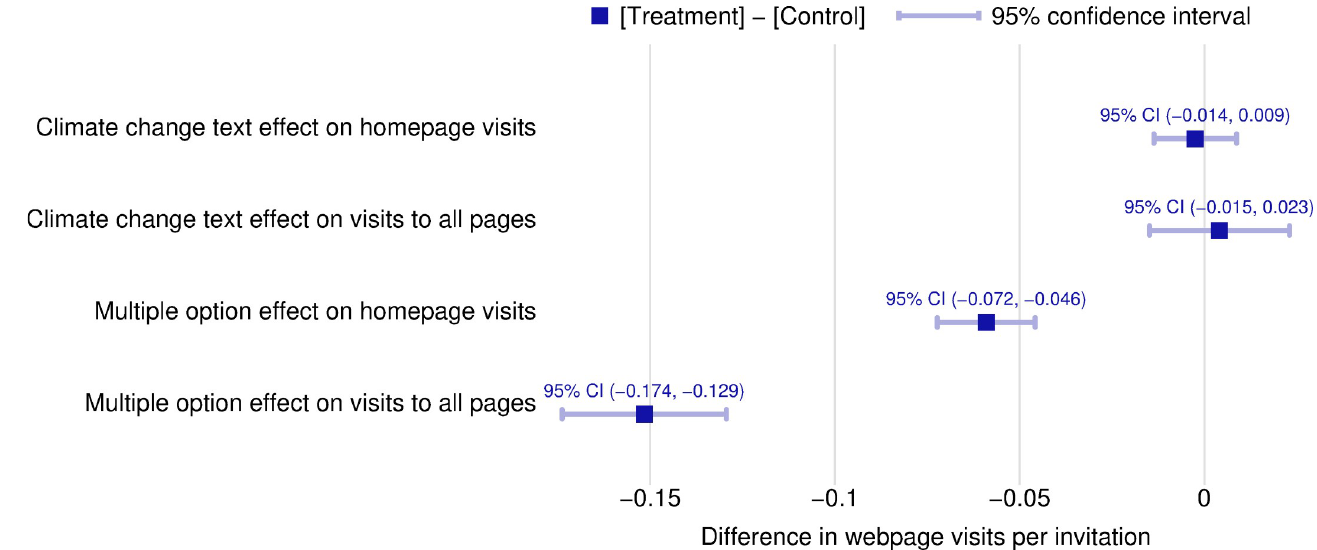
Fig 3. Treatment effects. See Fig 1